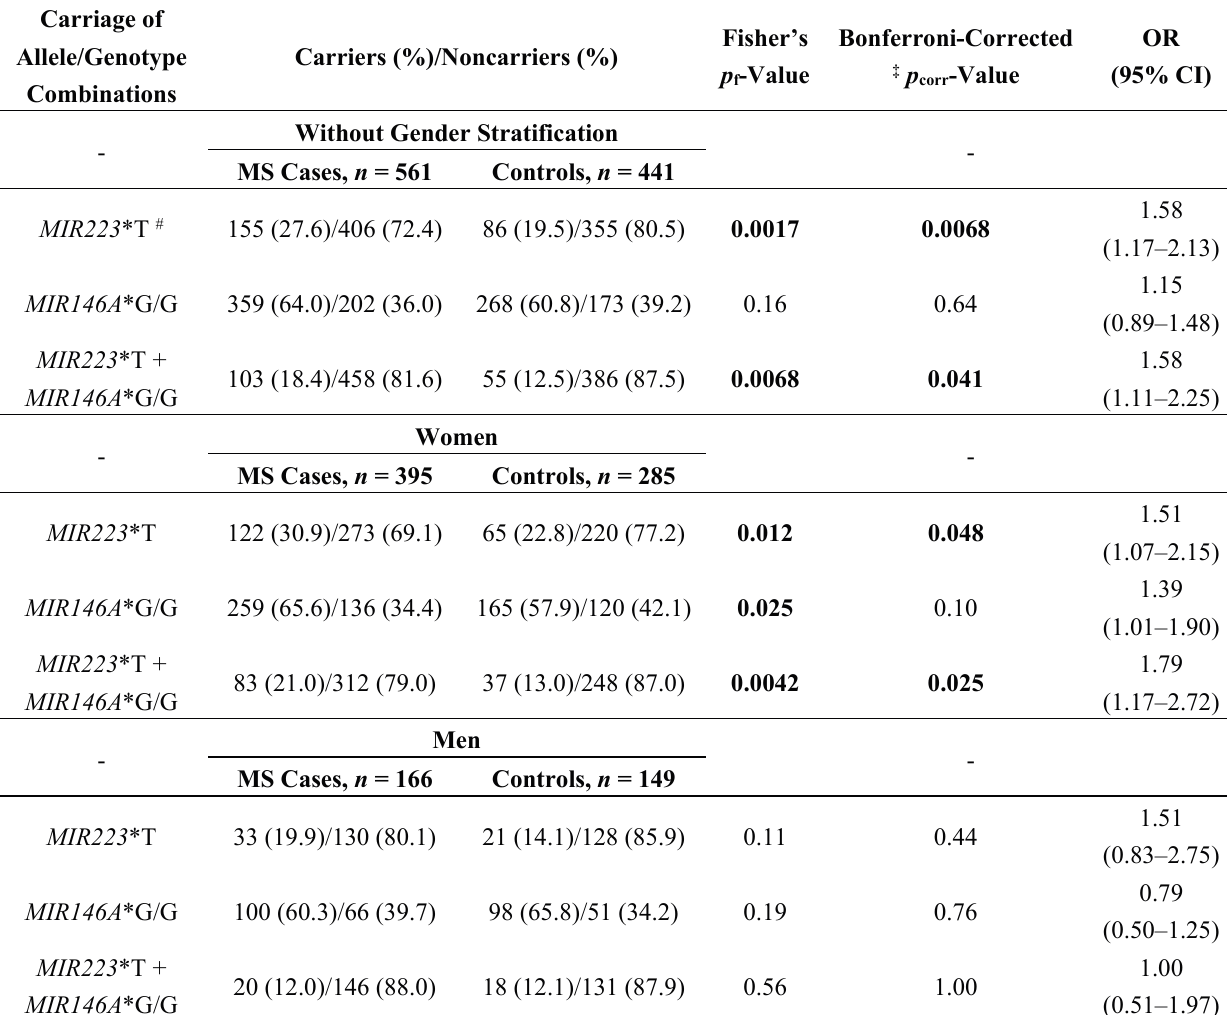
Table 1. Positive associations of SNPs in miRNA genes with MS risk †